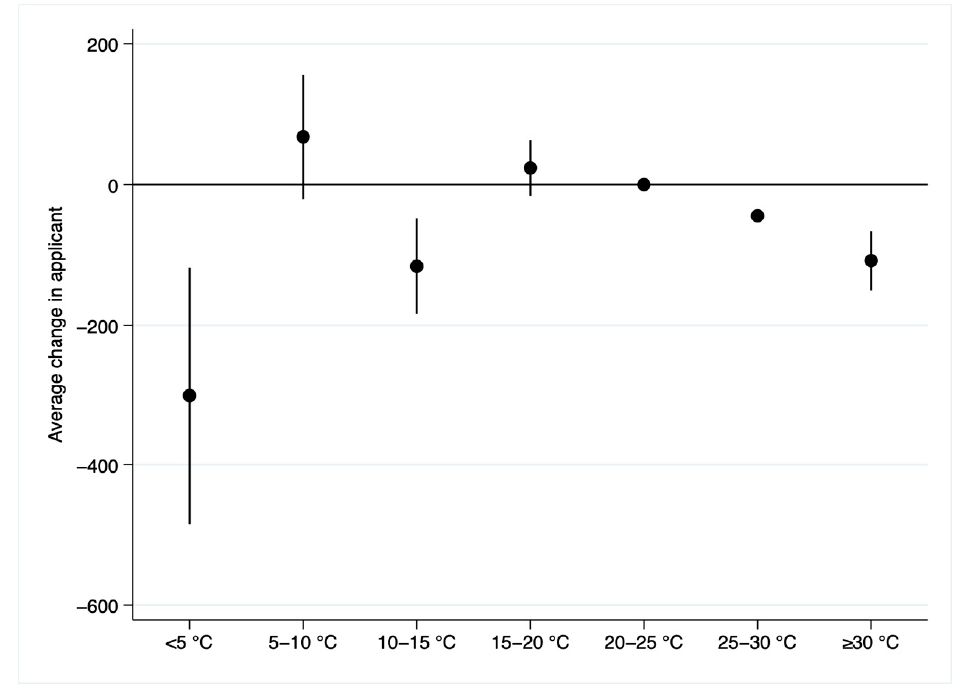
Figure 5. Estimated impacts of average temperature on the number of applicants for the UNGEE.